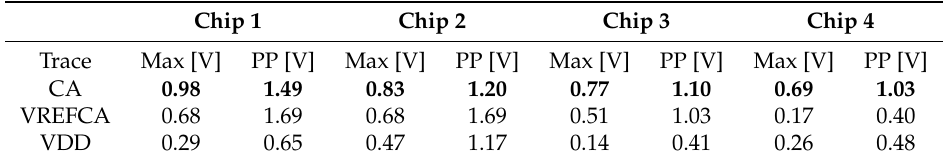
Table 4. Induced voltages across sensitive trace around each chip of DDR4 module (see waveform in Figure 12b) (bold depicts the sensitive net around each chip